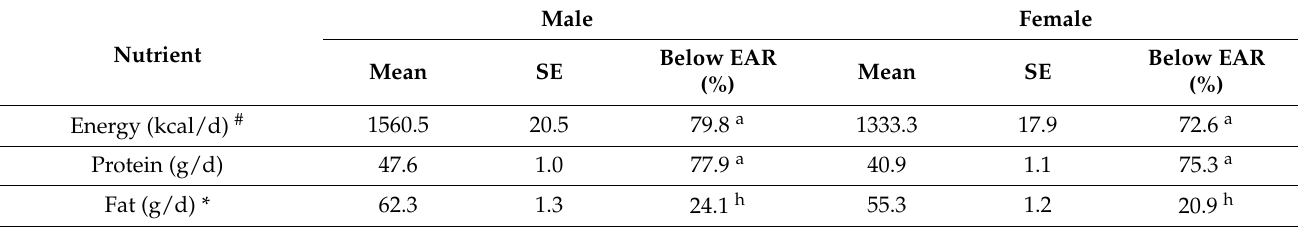
Table 4. Dietary daily intake of energy and nutrients and the prevalence of deficiency in the subjects aged 80 and above in different